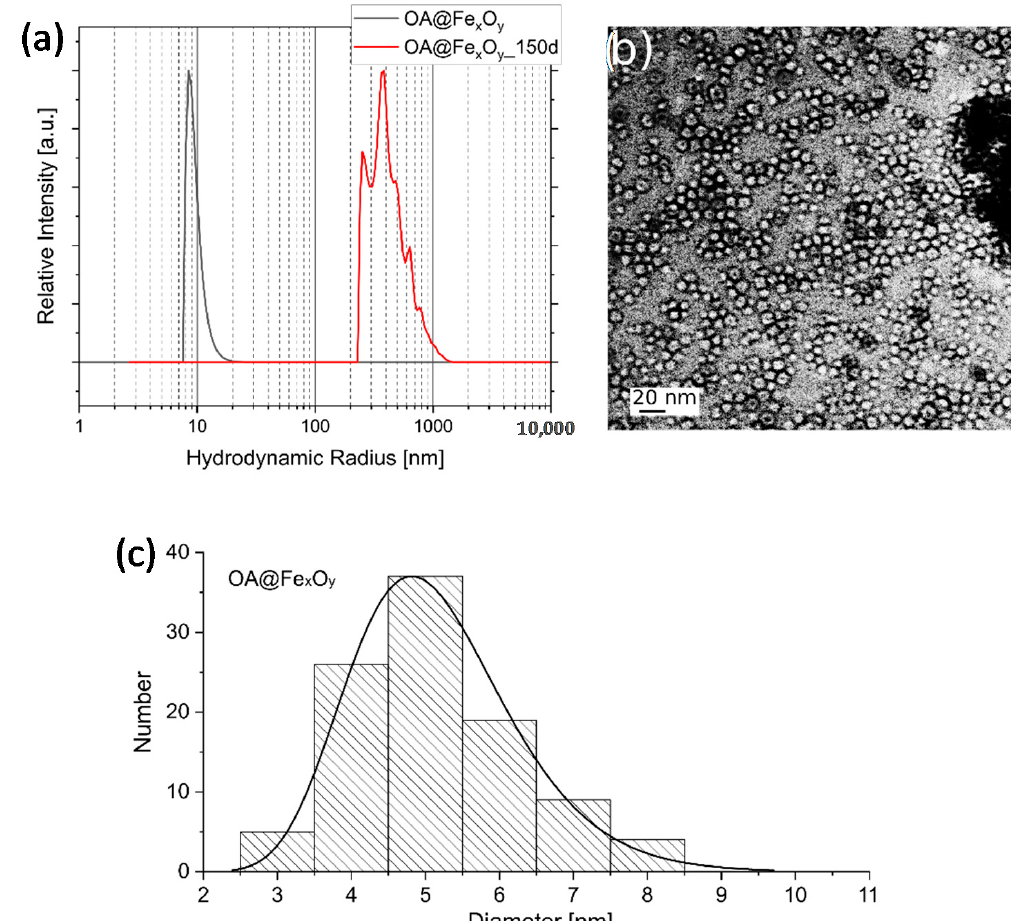
Figure 2 . OA@Fe x O y nanoparticles: ( a ) DLS curves in hexane, ( b ) TEM images, and ( c ) size distribution histograms obtained from 100 particles.